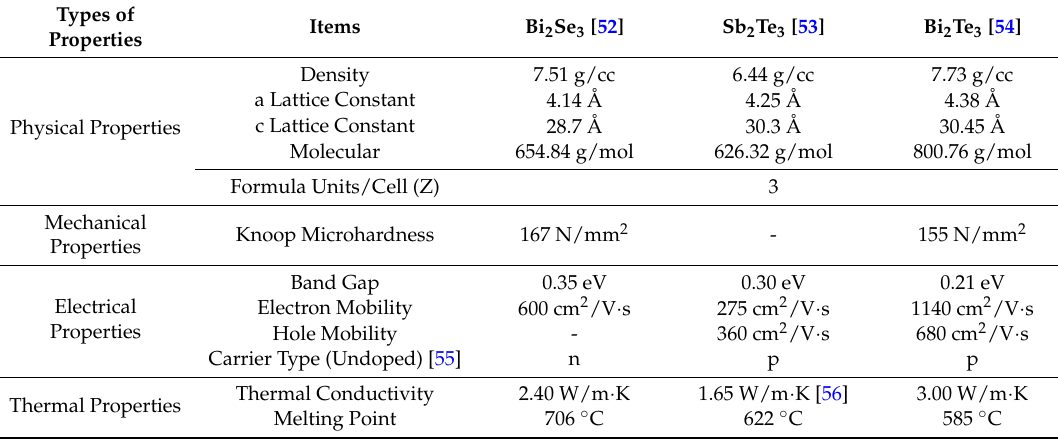
Table 1. The properties of common TIs.